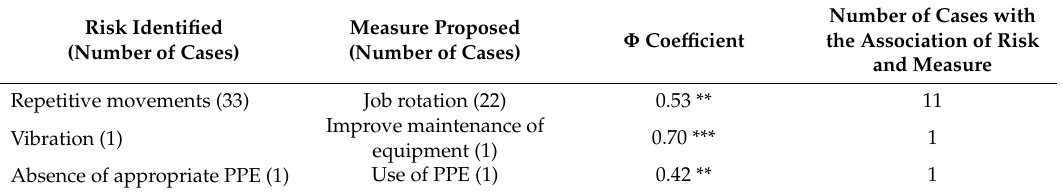
Table 11. Significant associations between risk identified and measures